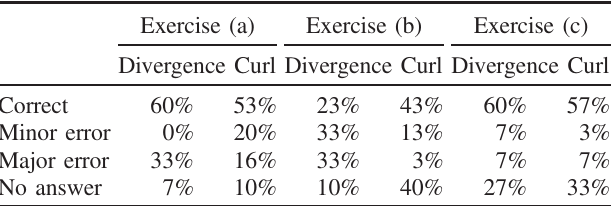
TABLE III. Categorization of students ’ calculations of the divergence and curl of three vector fields in the pretest ( N ¼ 30 ). Exercise